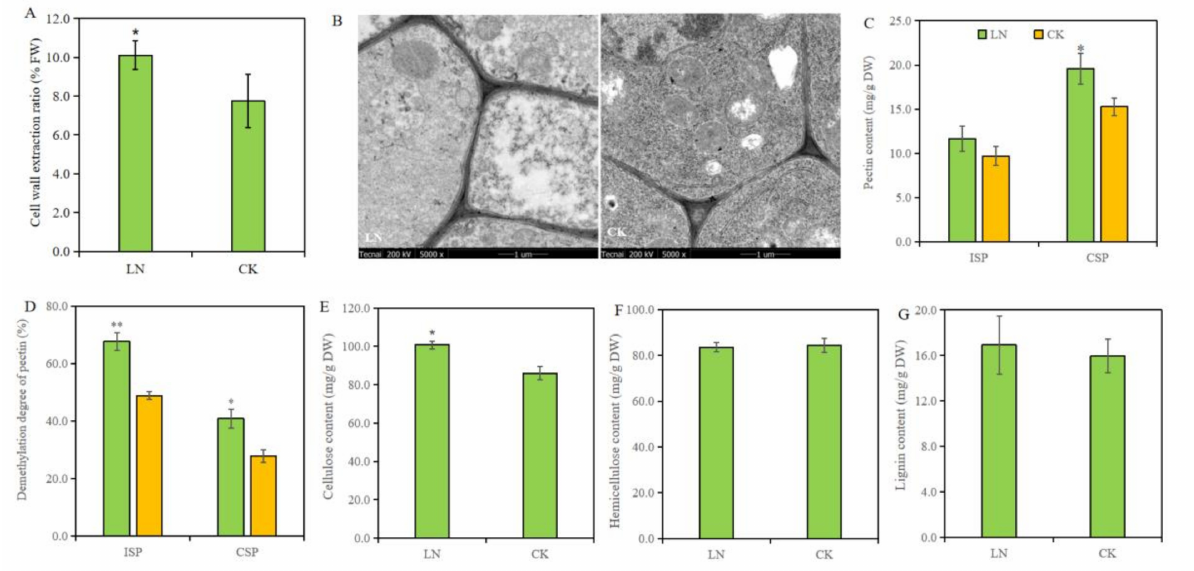
Figure 3. The responses of cell wall structure and compositions to different N treatment. ( A ) Cell wall extraction ratio; ( B ) TEM images of roots; ( C , D ) content and demethylation degree of ionic soluble pectin (ISP) and chelated soluble pectin (CSP); ( E – G ) concentrations of cellulose, hemicellulose, and lignin in root cell walls. The * and ** represent the statistical significances at the levels of p < 0.05 and p < 0.01,